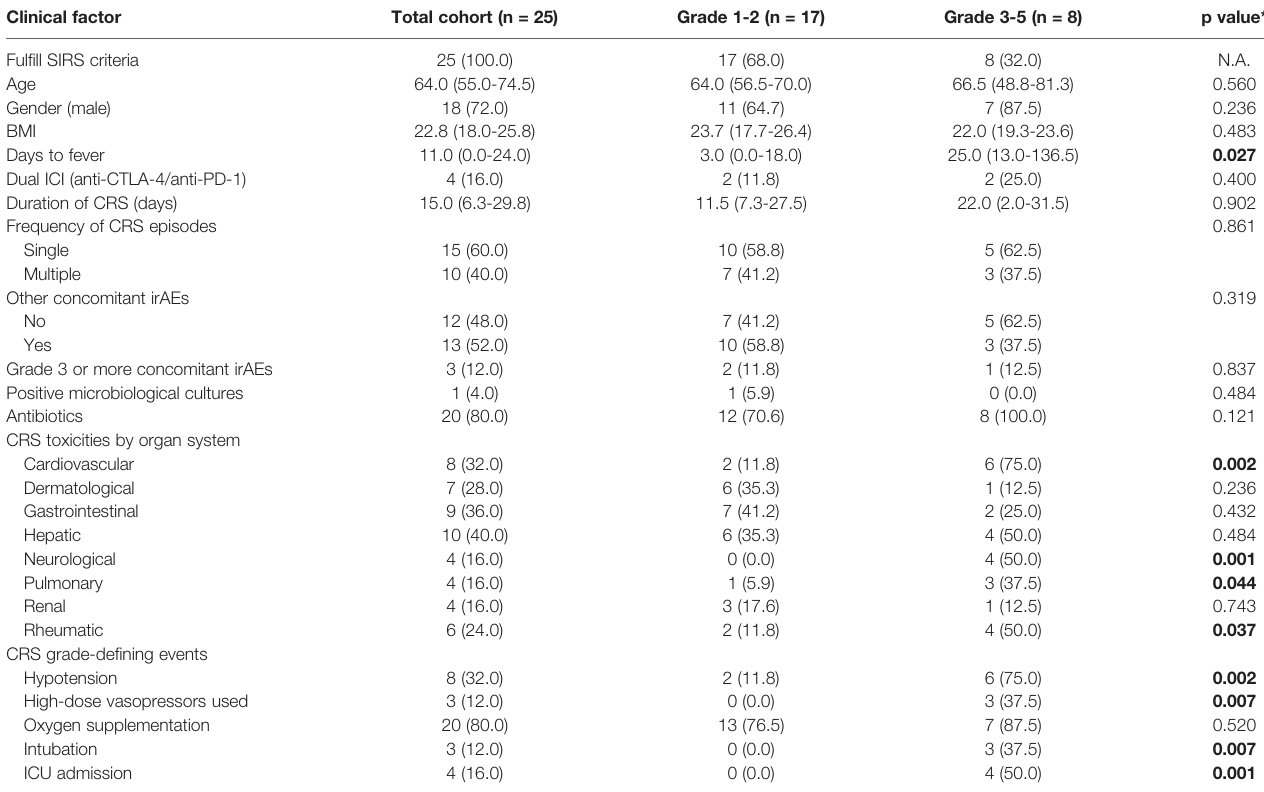
TABLE 2 | Clinical factors related to CRS. Clinical